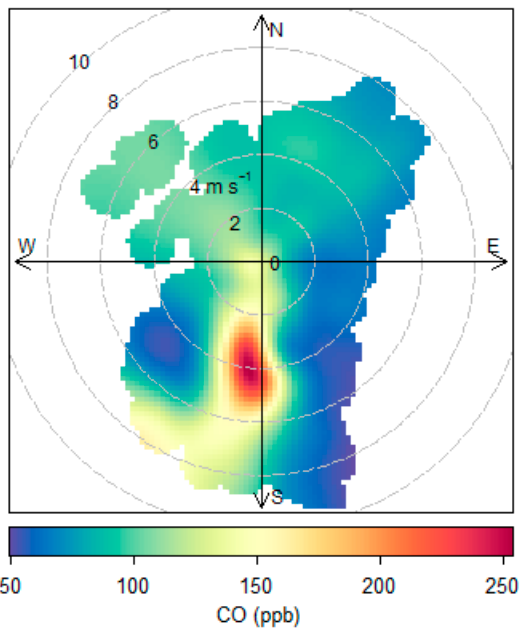
Figure 3. Bivariate polar plot showing CO mole fraction (ppb) variability as a function of wind speed (m · s − 1 ) and wind direction during the MUMBA campaign. Wind speed is represented by the concentric circles and wind direction is shown as compass directions, such that the shape of the coloured area illustrates the wind speeds and directions experienced during the campaign. The colour indicates the mean CO mole fraction measured under the corresponding wind conditions. All such figures in this study were created using the “openair” statistical tools for analysing air quality data using the software package R [51].